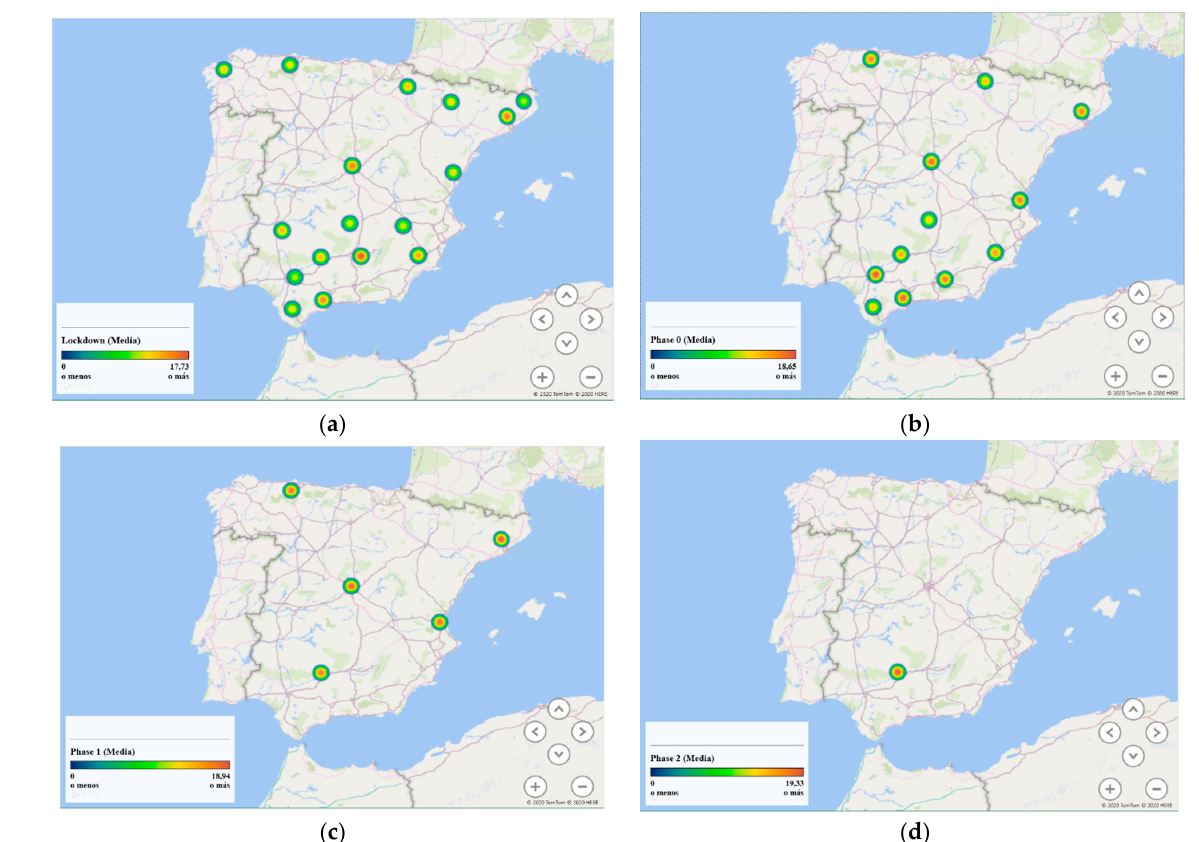
Figure 6. Bubble map of loudness during outbreak: ( a ) lockdown; ( b ) phase 0; ( c ) phase 1; ( d ) phase 2.